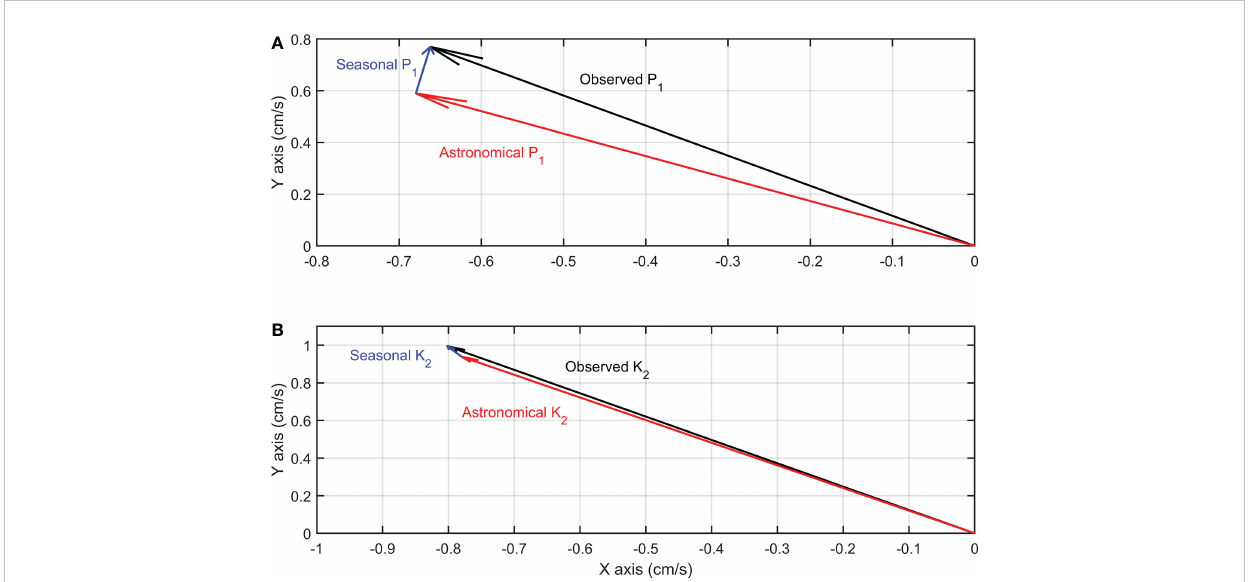
FIGURE 5 (A) The vectorial synthesis of the seasonal P 1 tide (blue arrow) and the astronomical P 1 tide (red arrow) generates the observed P 1 tide (black arrow). (B) Same as A, but for K 2 tide.